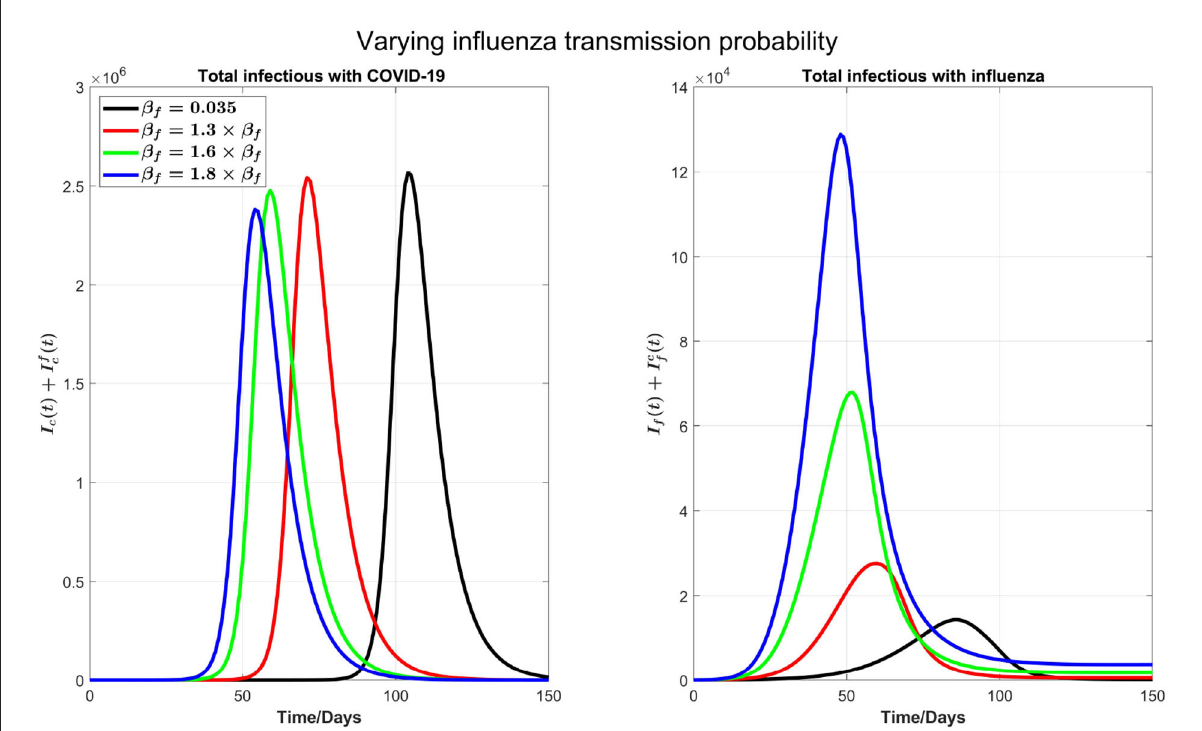
FIGURE3 The impact of varying the transmission probability β f on COVID-19 and influenza disease prevalence. Left plot represents the total number of infections with COVID-19 ( I c ( t ) + I f c ( t )) and right plot shows the total number of infections with influenza ( I f ( t ) + I c f ( t )).